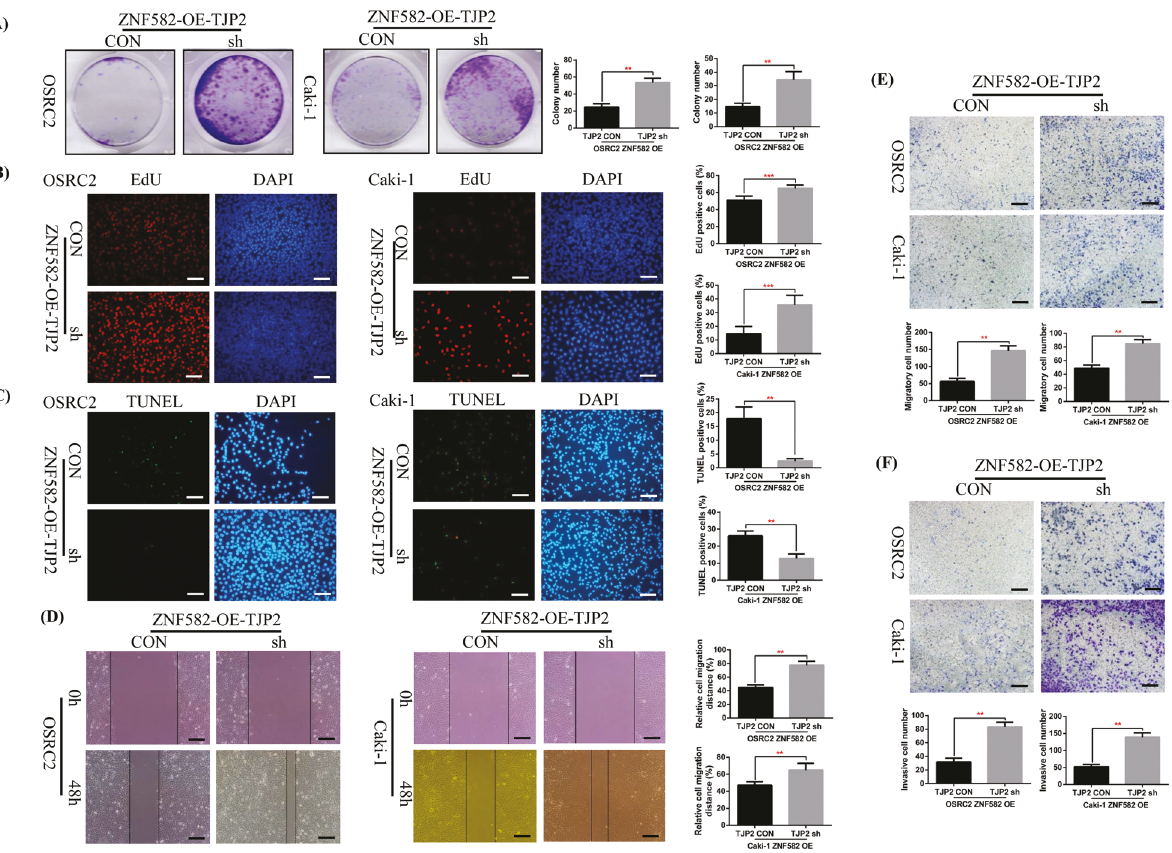
Fig. 7 Knockdown of TJP2 expression reverses the phenotype inhibition of ccRCC cell caused by ZNF582 overexpression in vitro. A Comparison of the number of cell clones in TJP2 knockdown and control OSRC2 and Caki-1 cells. Comparison of the proportion of EdU ( B ) and TUNEL ( C ) positive cells in TJP2 knockdown and control OSRC2 and Caki-1 cells by immuno fl uorescence (200X, Bar: 50 um). D Wound healing assay determined the migratory distances of TJP2 knockdown and control OSRC2 and Caki-1 cells (100X, Bar: 100 um). Comparison of cell migration ( E ) and cell invasion ( F ) ability in TJP2 knockdown and control OSRC2 and Caki-1 cells (100X, Bar: 100 um). The presentation of the histogram was the result of three independent experiments. ** P < 0.01, *** P < 0.001, compared with the corresponding